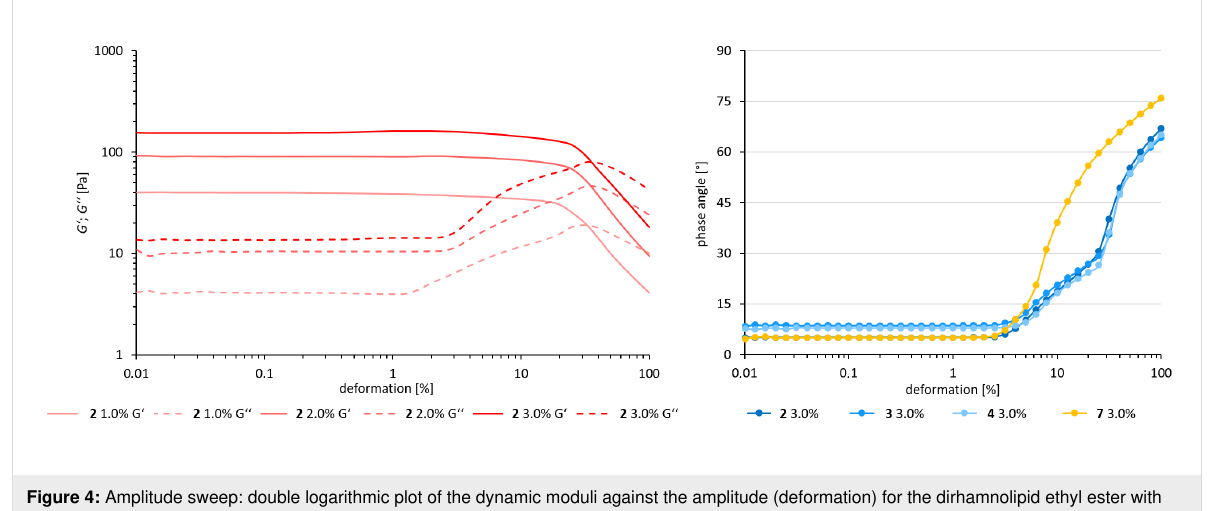
Figure 4: Amplitude sweep: double logarithmic plot of the dynamic moduli against the amplitude (deformation) for the dirhamnolipid ethyl ester with different concentrations in toluene (left), and a plot of the phase angle against the amplitude for the different dirhamnolipid esters (right) at 15 °C and a frequency of 1